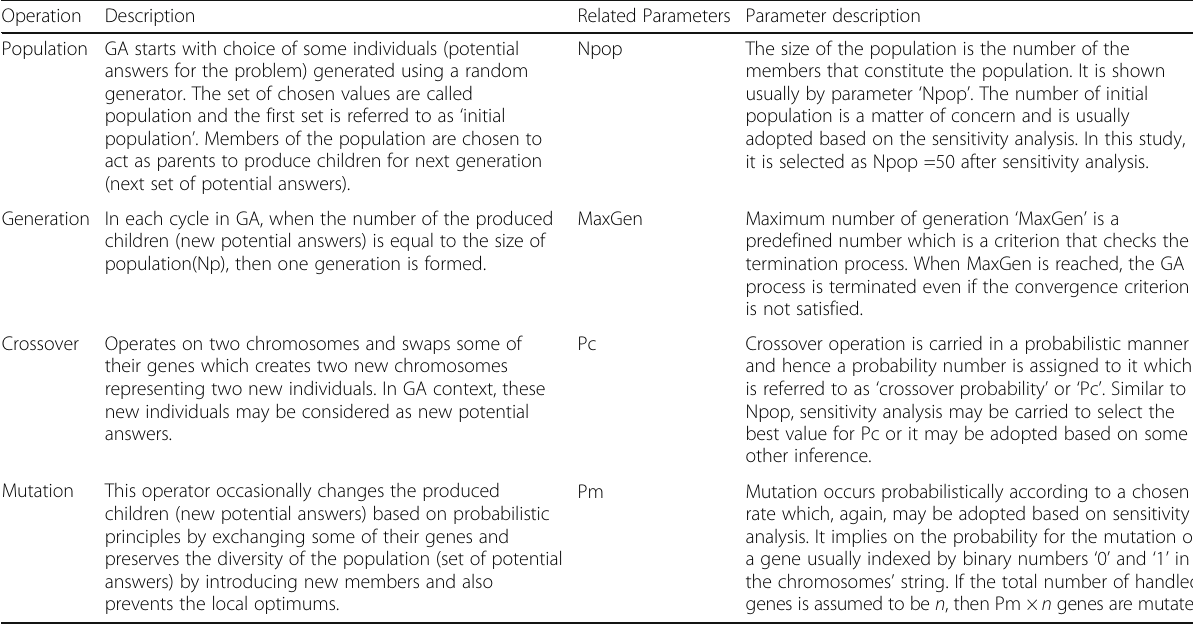
Table 1 Operation description and related parameter in GA